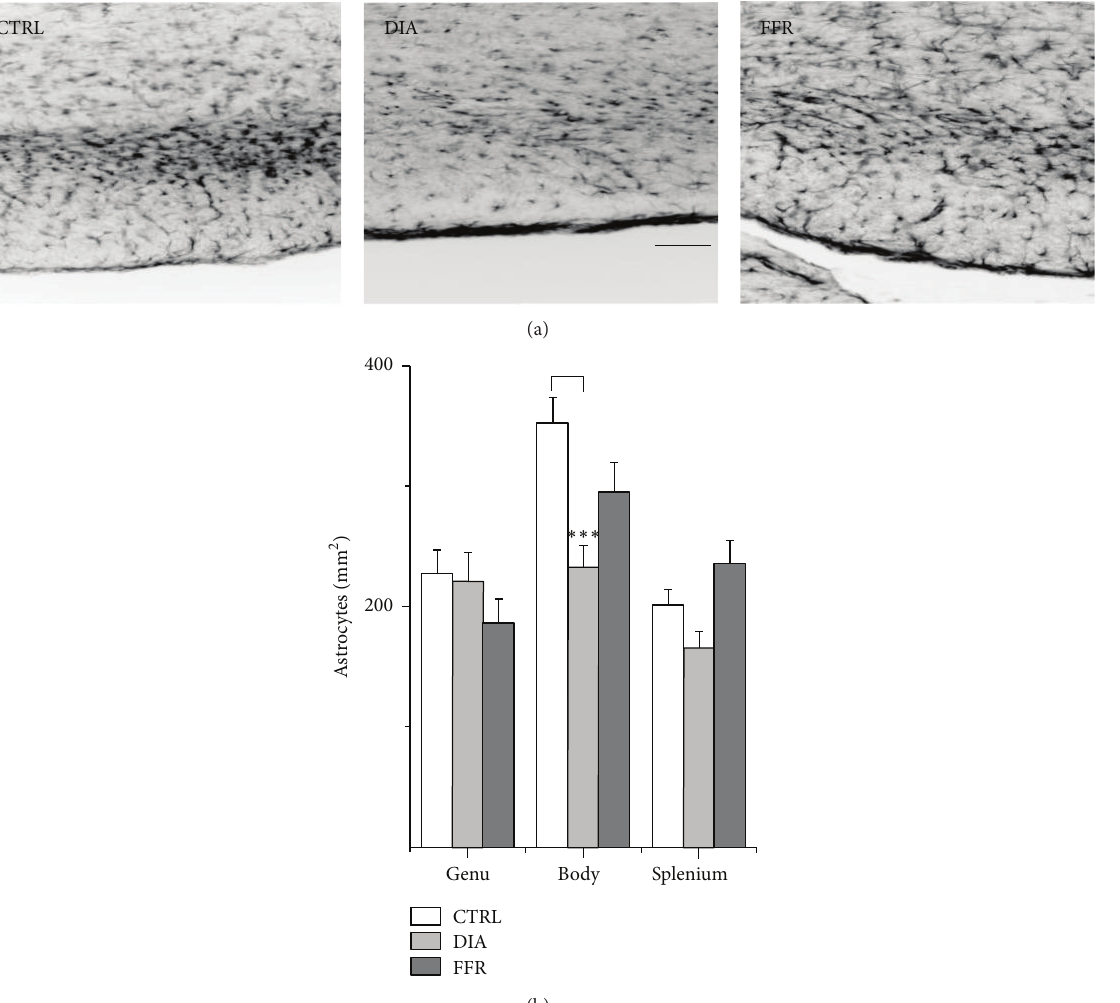
Figure 3: Dehydration-induced anorexia (DIA) reduces astrocyte density in the body of rat CC. (a) Histological sections of the body of rat CC show GFAP staining in control (CTRL), dehydration-induced anorexia (DIA), and forced food-restricted (FFR) groups. (b) No differences in astrocyte density between control, DIA, or FFR groups were found in the genu ( 𝑛 ≥ 23 ) or the splenium ( 𝑛 ≥ 20 ). In contrast, a significant reduction in astrocyte density was observed in the caudal body ( 𝑛 ≥ 26 ) for the DIA group ( − 34%). Scale bar = 100 𝜇 m. Data are mean ± S.E.M. ( ∗∗∗ 𝑃 < 0.001